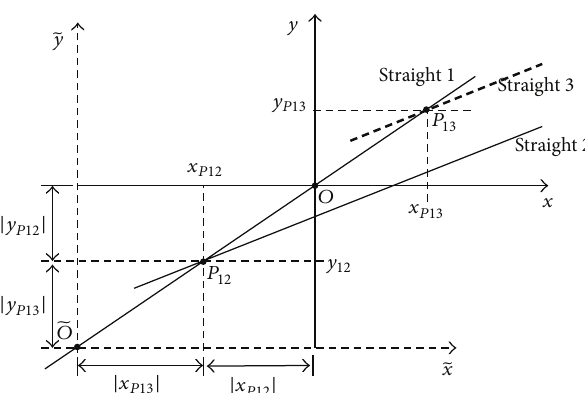
Figure 6: Idea of the procedure of correcting the coordinates of the origin of LCS